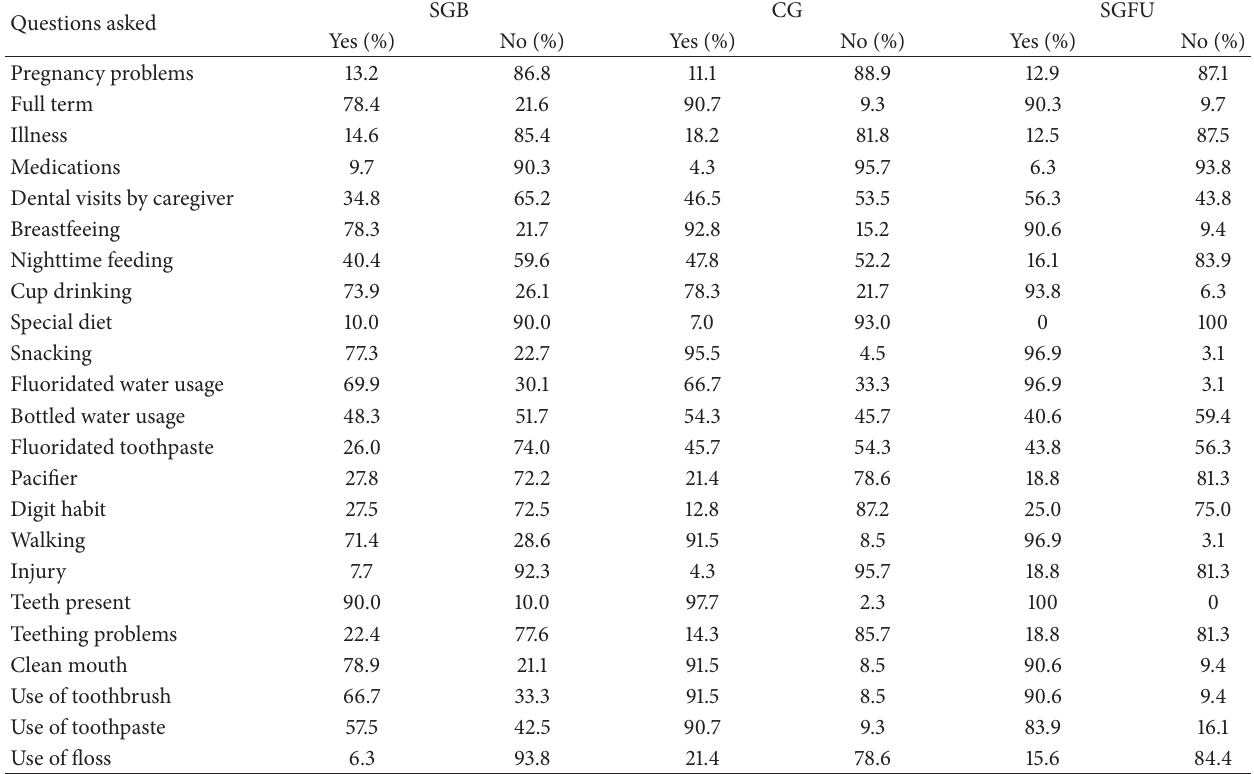
Table 2: Summary of data collected from assessment form for the SGB, CG, and SGFU.